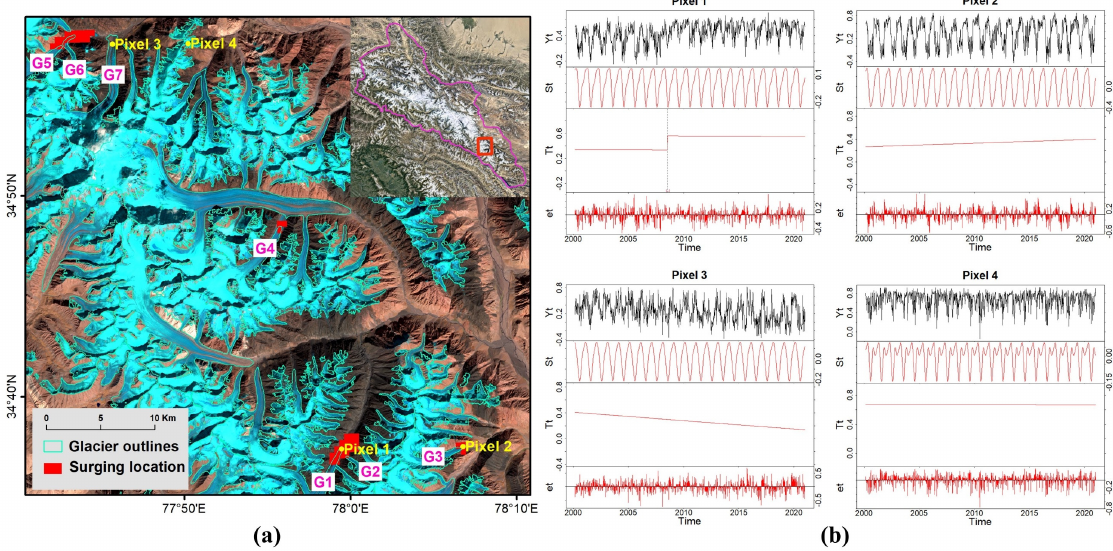
Figure 3. ( a ) Detection of grid clusters pertinent to glacier surging (red) and NDSI trend components at exemplified pixels. Pixel 1 and Pixel 2 represent two types of NDSI time series changes related to glacier surging. Pixel 3 and Pixel 4 are examples of nonsurging pixels around and within the glacier polygon. In ( a ), the background image is a false-color composite (band 6—SWIR1, 5—NIR, 4—Red as RGB) from Landsat 8 OLI acquired on 14 October 2020. ( b ) Glacier outlines are based on RGI v6.0. Results of the BFAST-decomposed components of surging and nonsurging pixels in the NDSI time series. In each plot, the four panels from top to bottom are the original NDSI time series of each pixel (Yt), seasonal component (St), trend component (Tt), and remainder component (et).